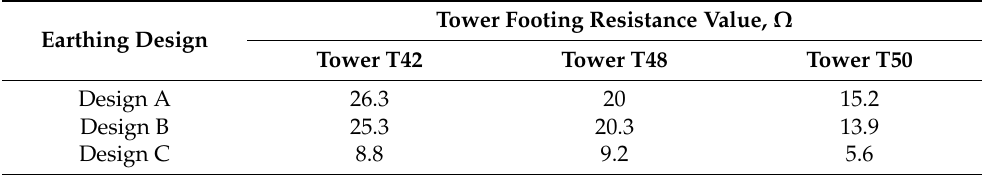
Table 5. Tower footing resistance analysis of different design arrangements.